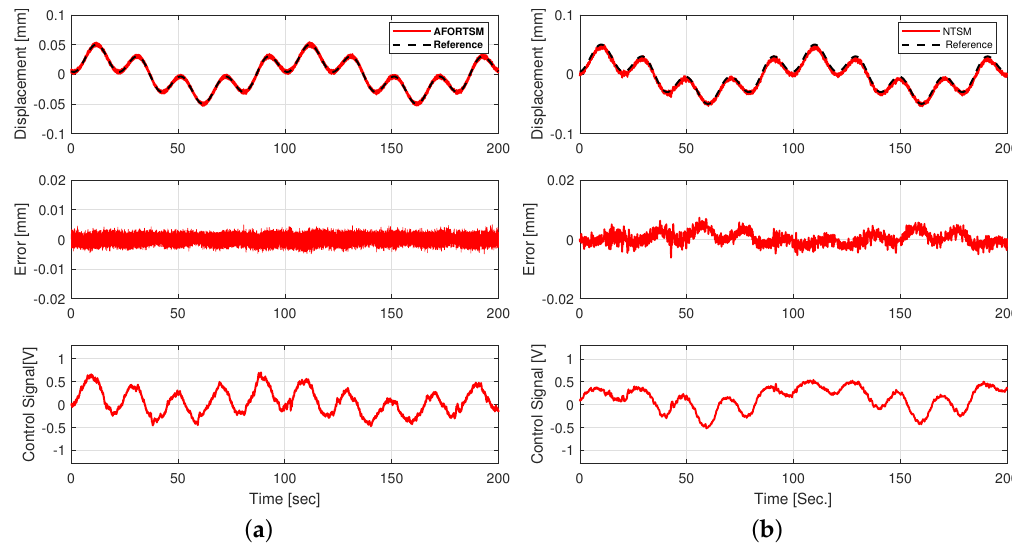
Figure 5. Test 4: Experimental results of AFORTSM and NTSM for tracking a dual-tone sinusoidal reference without uncertainties (top: tracking profiles; middle: tracking error; bottom: control signal). ( a ) AFORTSM; ( b ) NTSM.